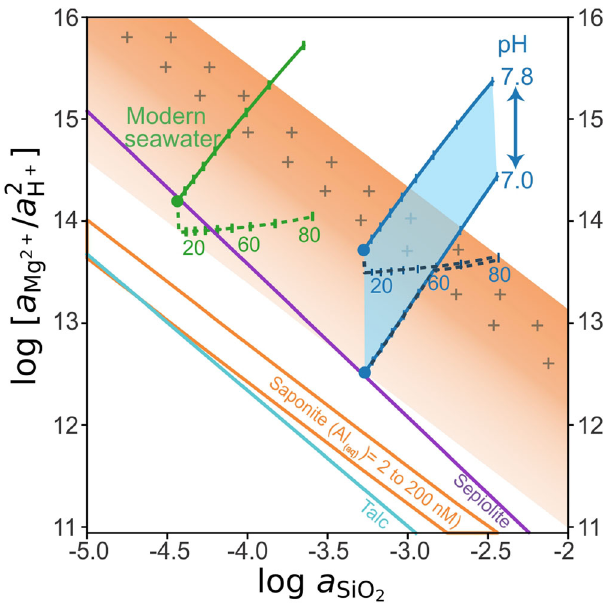
Fig. 7 Stability diagram of saponite and modeled evaporation pathways. Modern seawater (green) and Ediacaran seawater (blue). Talc stability boundary (turquoise), saponite stability boundary (orange), and sepiolite stability boundary (purple) are shown as a function of dissolved Mg, H, and Si activities. Filled circles represent starting conditions (0 evaporation), solid lines represent evaporation pathway with no mineral precipitation, and dashed lines represent evaporation pathways considering calcite precipitation (each hash along the two lines represents a 10% step in evaporation). Two different pH starting conditions are modeled for Ediacaran seawater (7.0 and 7.8) to create the envelope of potential results. Orange gradient shading is parallel to saponite stability lines and its upper and lower boundary cross the starting point at 7.0pH and 80% evaporation point with calcite precipitation of Ediacaran seawater pathway, respectively. The area with plus sign pattern shows the differences between modern and Ediacaran seawater after 80% evaporation, and represents potential range of the critical supersaturation. Temperature = 25°C, p CO 2 = 10 − 3